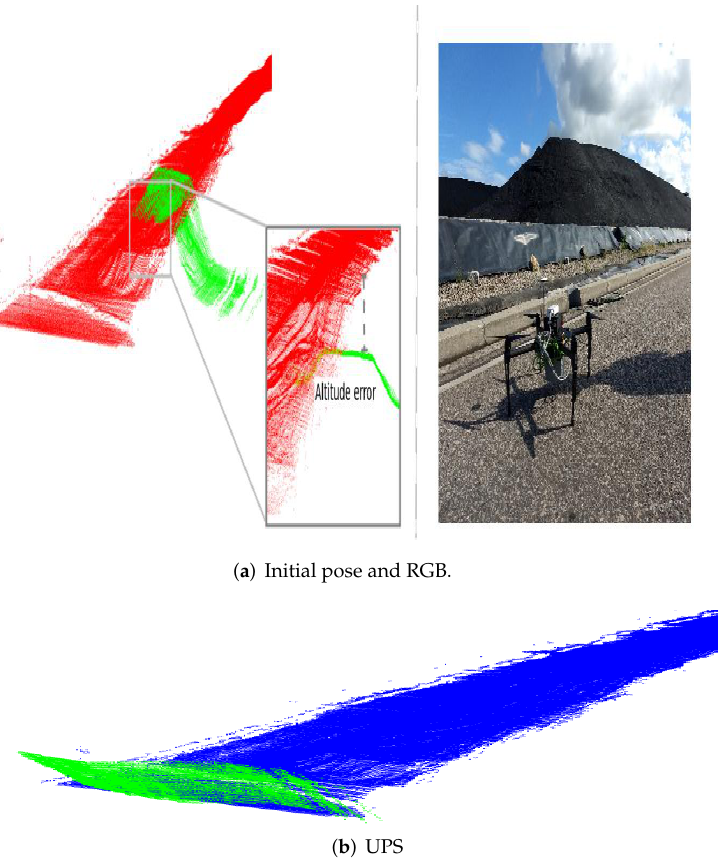
Figure 15. Stockpile scene bad-alignment under different densities and low-overlaping. In ( a ) initial pose and RGB image and ( b ) alignment